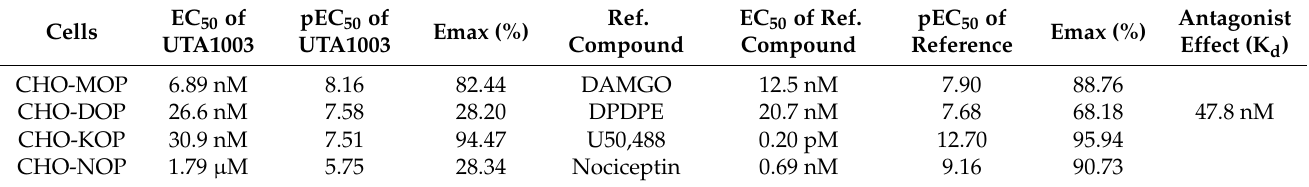
Table 1. Summary of receptor specificity and efficacy of UTA1003 for the major opioid